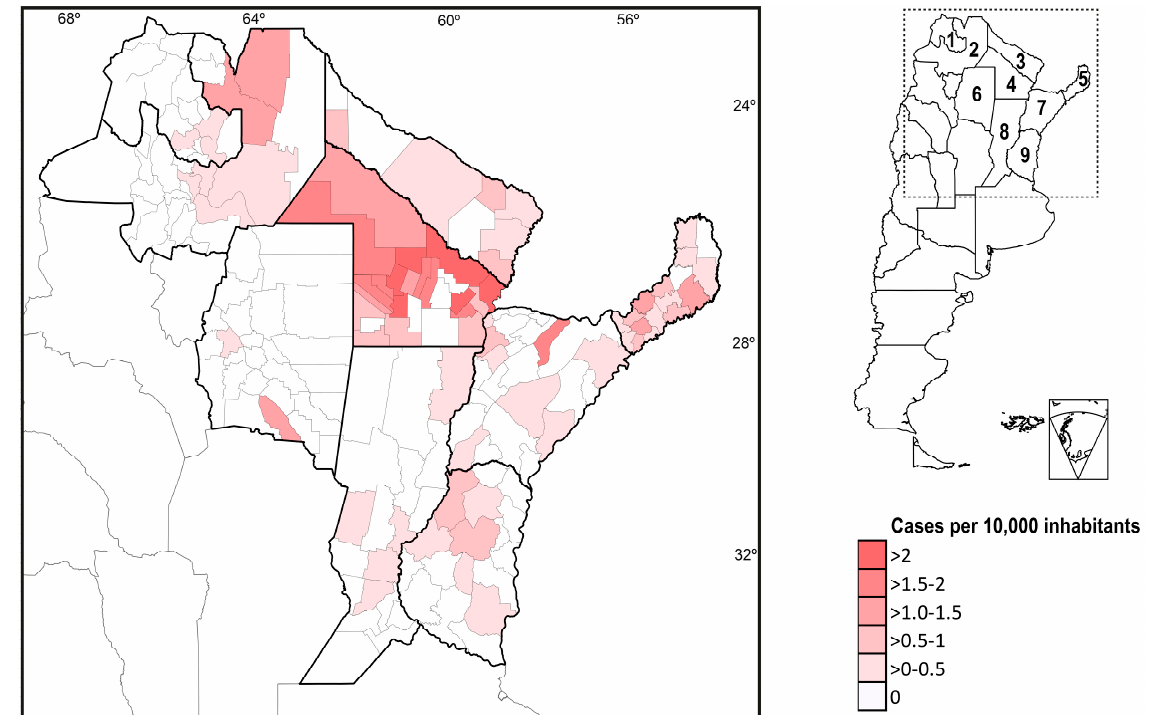
Figure 1. Temporal distribution of PCM cases in the period 2012–2021.